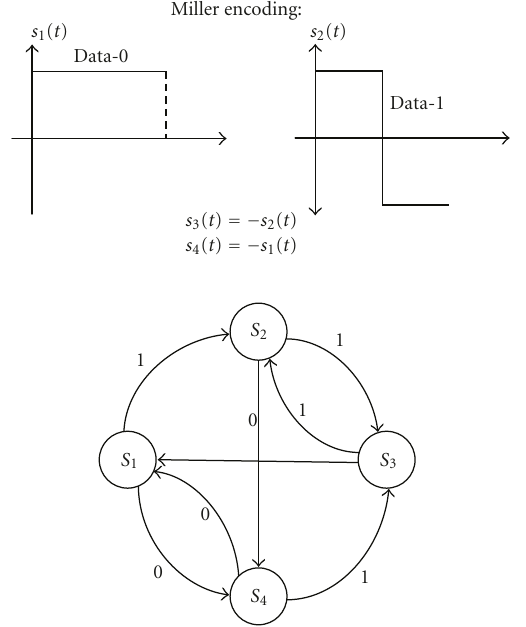
Figure 5: The Miller Encoding Scheme.